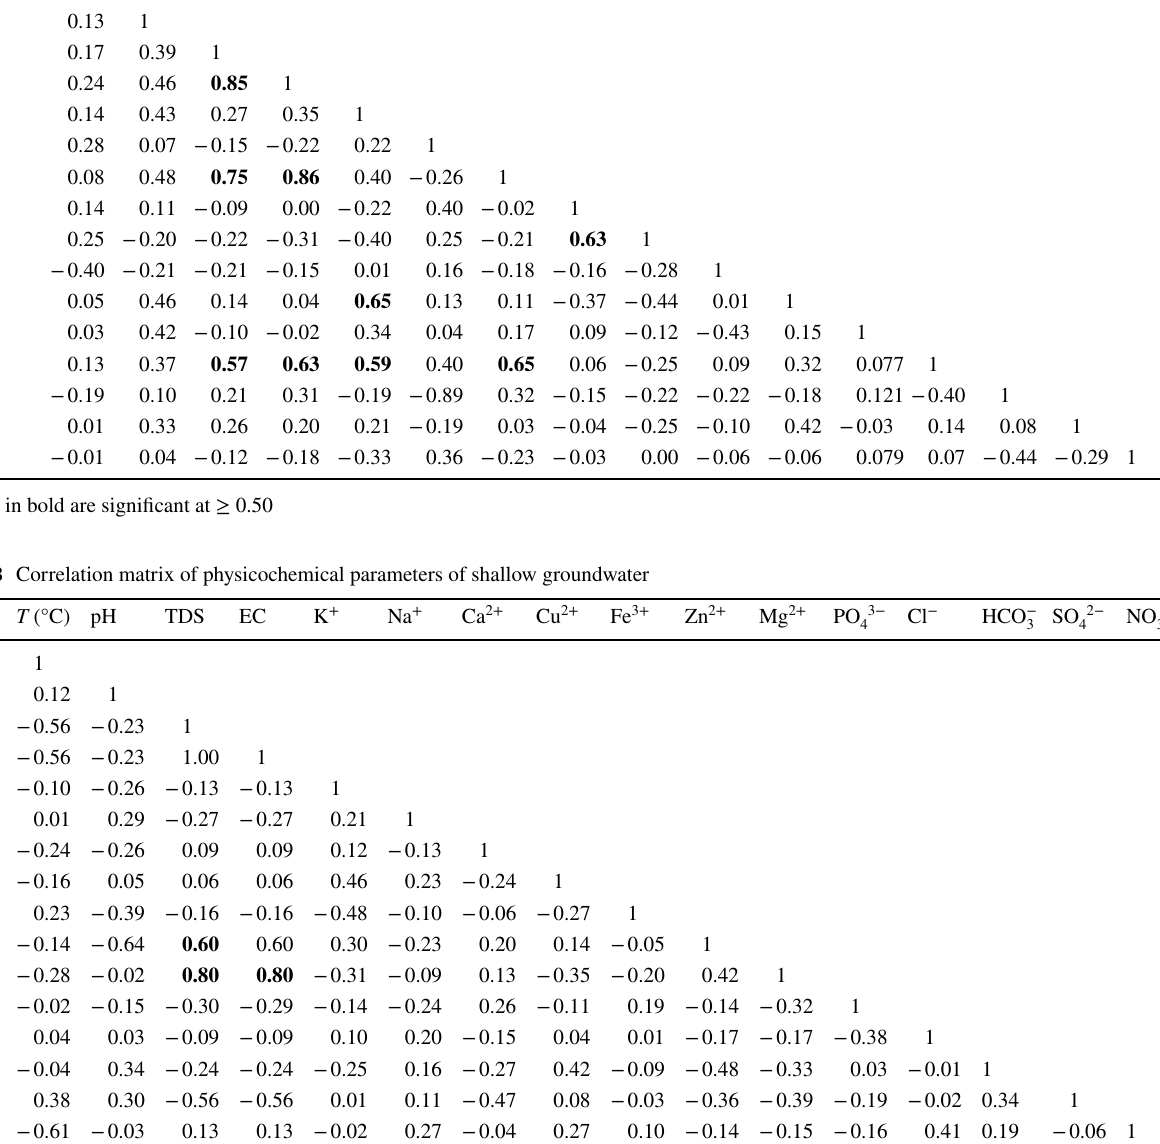
Values in bold are significant at ≥